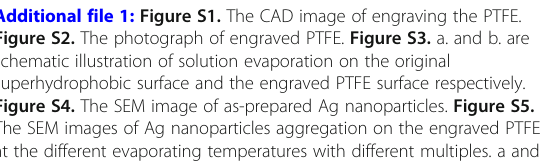
Additional file 1: Figure S1. The CAD image of engraving the PTFE. Figure S2. The photograph of engraved PTFE. Figure S3. a. and b. are schematic illustration of solution evaporation on the original superhydrophobic surface and the engraved PTFE surface respectively. Figure S4. The SEM image of as-prepared Ag nanoparticles. Figure S5. The SEM images of Ag nanoparticles aggregation on the engraved PTFE at the different evaporating temperatures with different multiples. a and